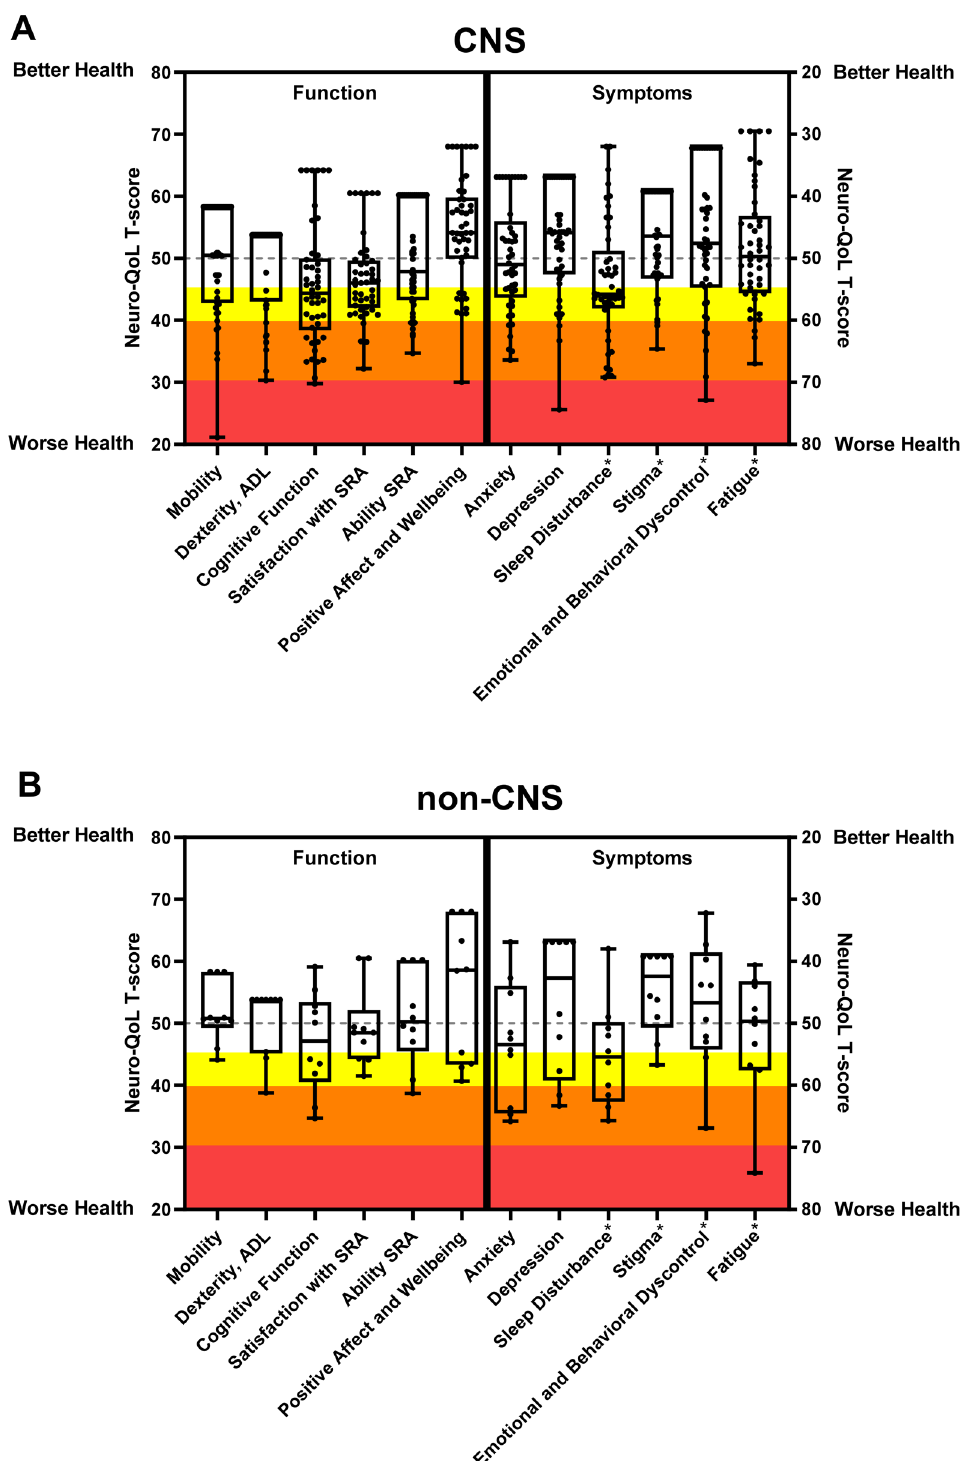
Figure 1. Patient reported quality of life following microbial recovery from cryptococcosis by population scaled Neuro-QoL domains. ( A ) subjects with CNS cryptococcosis (n = 46). ( B ) non-CNS cryptococcosis subjects (n = 10). Box plots show median, 25th, and 75th percentiles. The yellow region designates mild symptoms or impairment, orange, moderate, and red, severe. The gray dotted line represents the mean T-score (50) of the U.S. population reference for each Neuro-QoL domain. The asterisk* indicates measures that were centered to U.S. clinical reference population. All other domains were centered to a U.S. general population reference. Abbreviations: CNS, central nervous system, ADL, activities of daily living, SRA, social roles and